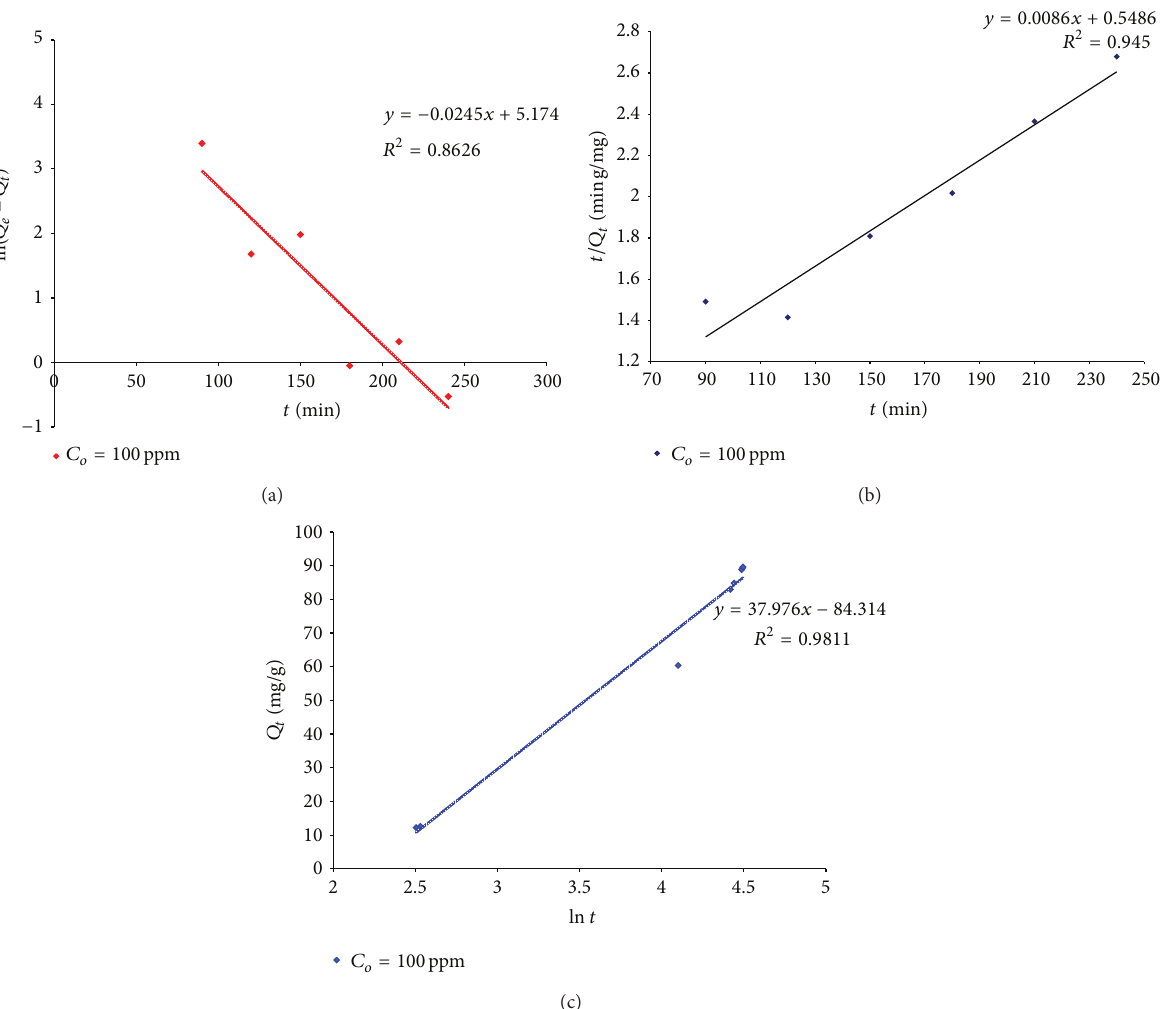
Figure 6: The linear plots, (a) pseudo-first-order and (b) pseudo-second-order, (c) Elovich kinetic models for the adsorption of methylene blue onto activated carbon prepared from kola nut